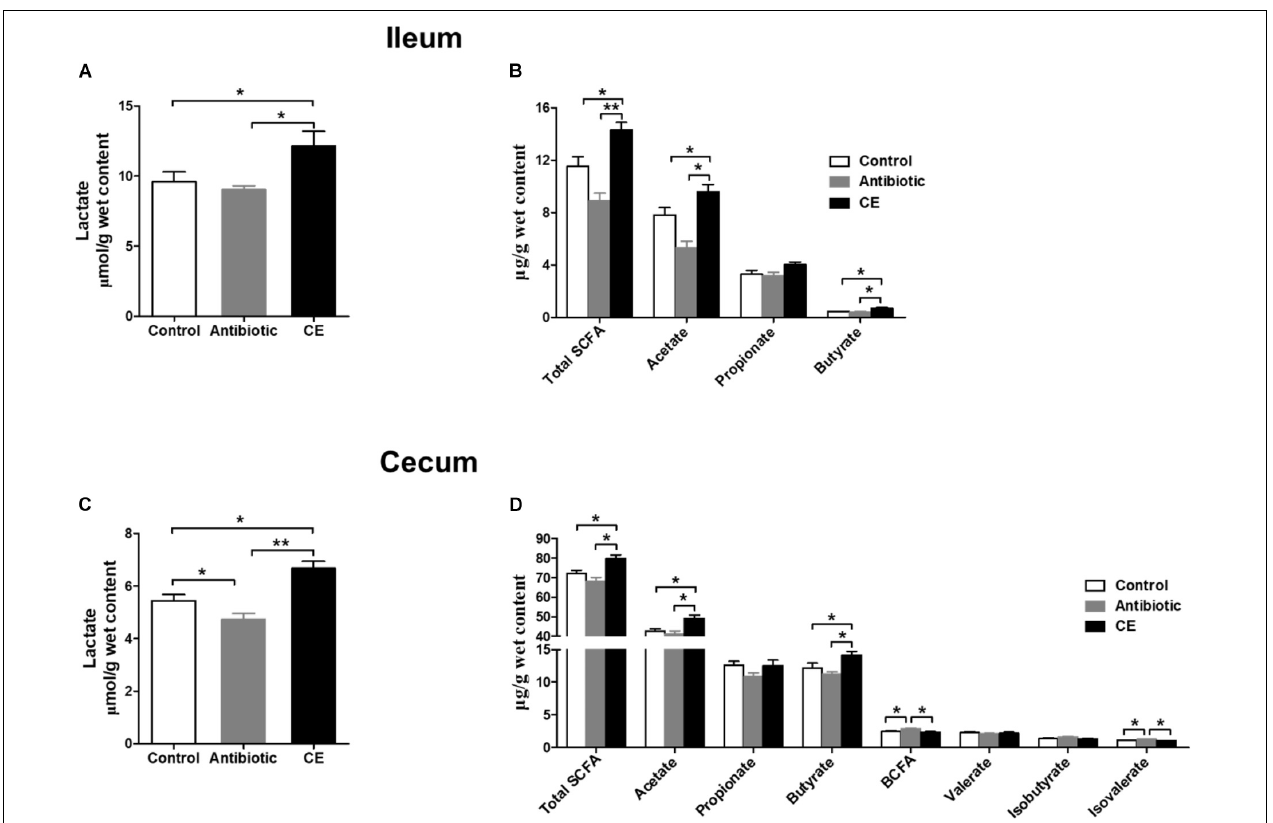
FIGURE 5 | Effect of the dietary supplementation with citrus extract on the carbohydrate metabolites in the ileal and cecal digesta of Chinese yellow feathered broilers: (A) Ileal lactate, (B) Ileal SCFAs, (C) Cecal lactate, and (D) cecal SCFAs. The values are means ± SEM. Asterisks indicate statistical differences between different groups (one-way ANOVA with a Tukey post hoc test): ∗ P < 0.05. Total SCFA, total short-chain fatty acid; BCFA, branched-chain fatty